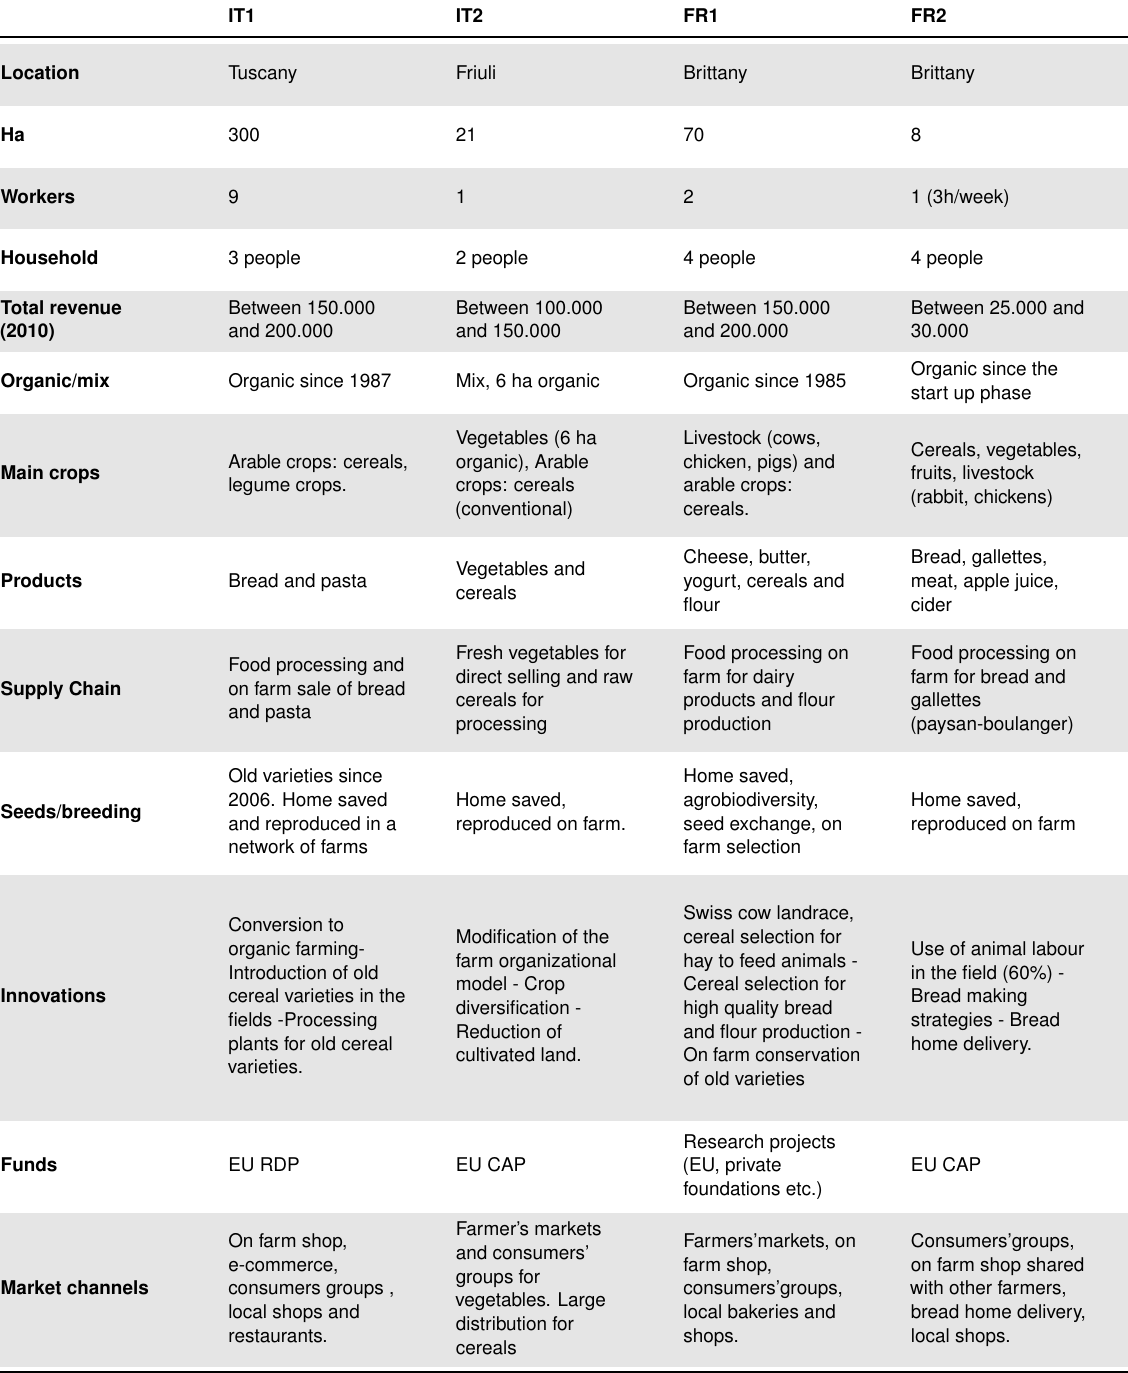
Table 1. Main features of the four case study